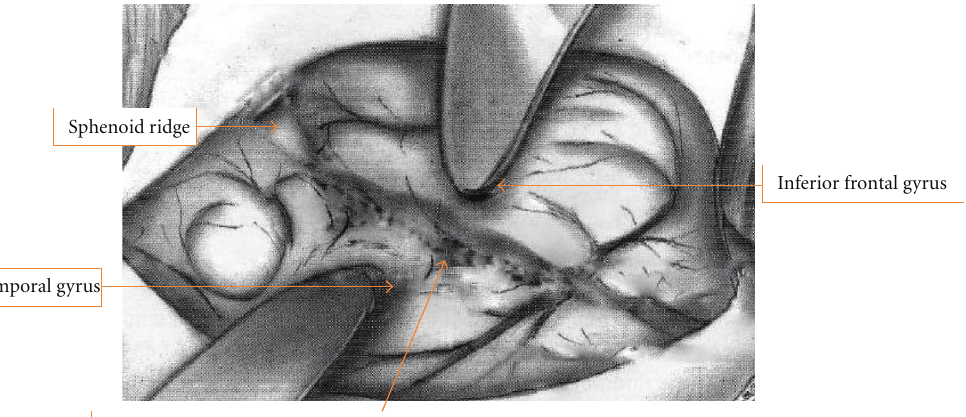
Figure 3: Diagram showing the “valve”-like structure on the surface of the